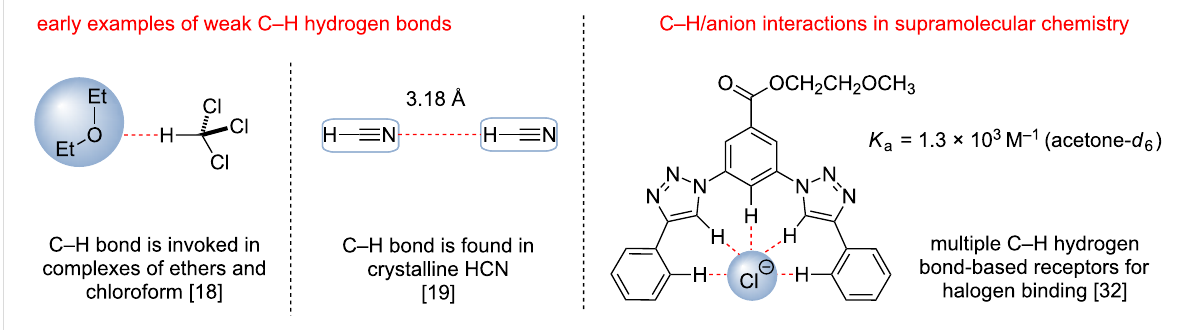
(C–X···X or C–X···A interactions) in organocatalyst